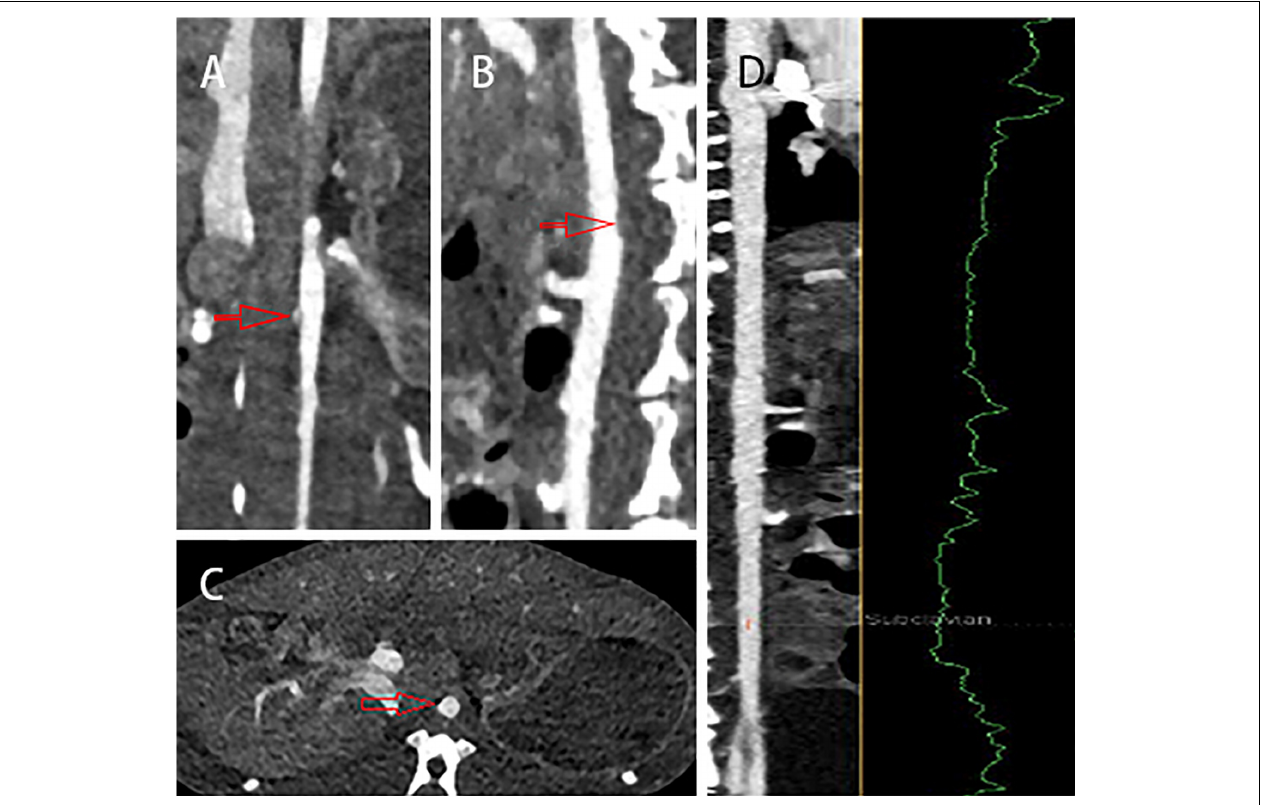
FIGURE 5 | The (A) coronal, (B) sagittal, and (C) cross-sectional CT scans showed that the wall of abdominal aorta was thickened and irregular (red arrow), but there was no obvious sign of atherosclerotic plaques. (D) In addition, there was no significant stenosis in the whole abdominal